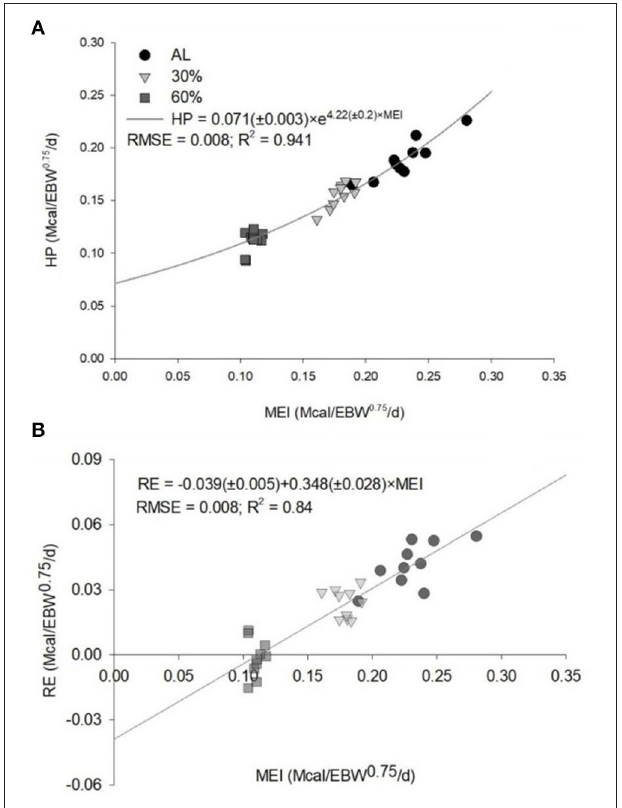
FIGURE 1 | Predicted equations by the relationships (A) between the heat production (HP) and the metabolizable energy intake (MEI) and (B) between the retained energy (RE) and the MEI of ad libitum (AL), 30% of feed restriction (30%) and 60% of feed restriction (60%) of intact male Dorper × Santa Ines lambs. EBW, empty body weight; RMSE, root mean square